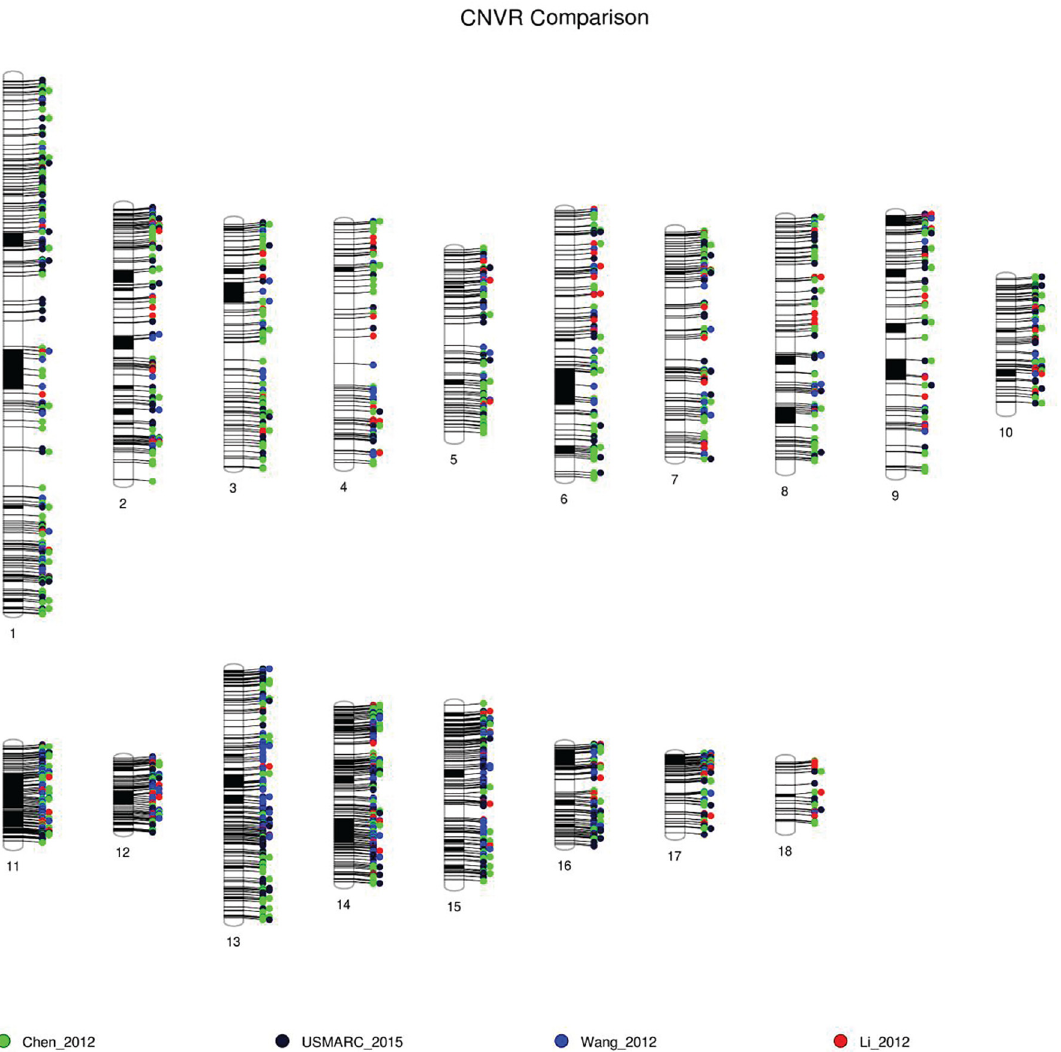
Fig 1. Comparison of CNVR discovered in pigs. Comparison of CNVR discovered with the Illumina SNP60 BeadChip in the current study (USMARC_2015, black) with the results of Chen et al. [12] (Chen_2012, green) and Wang et al. [15] (Wang_2012, blue). In addition, the results of Li et al. [9], which used CGH arrays (Li_2012, red), are also displayed. Diagram was generated using PhenoGram